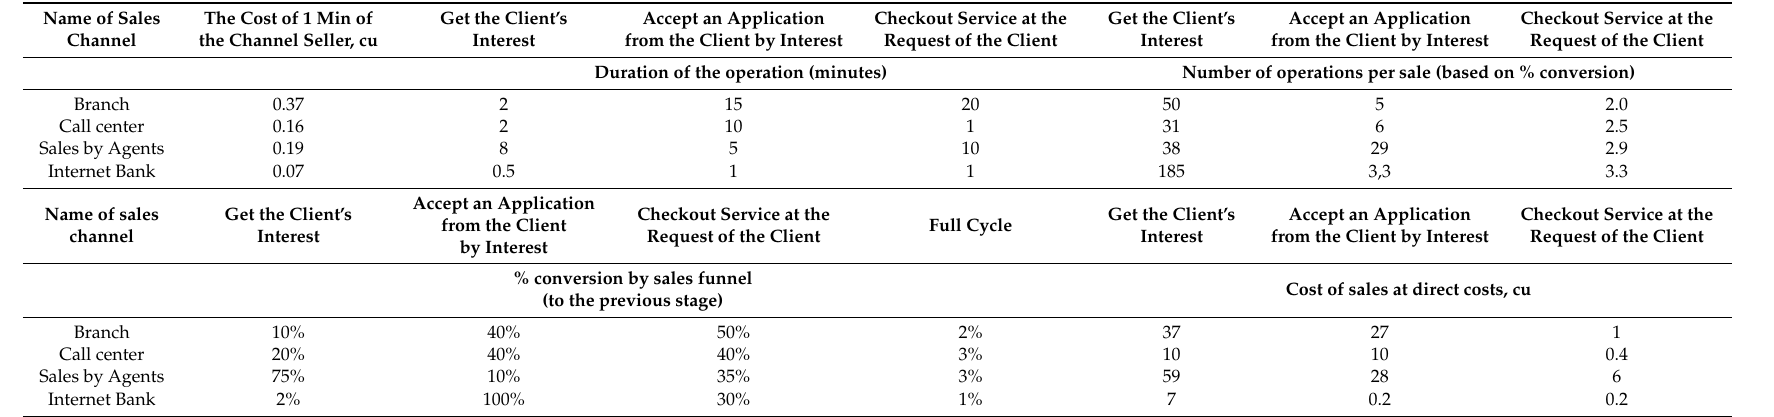
Table 2. Calculation of the cost of sales at direct